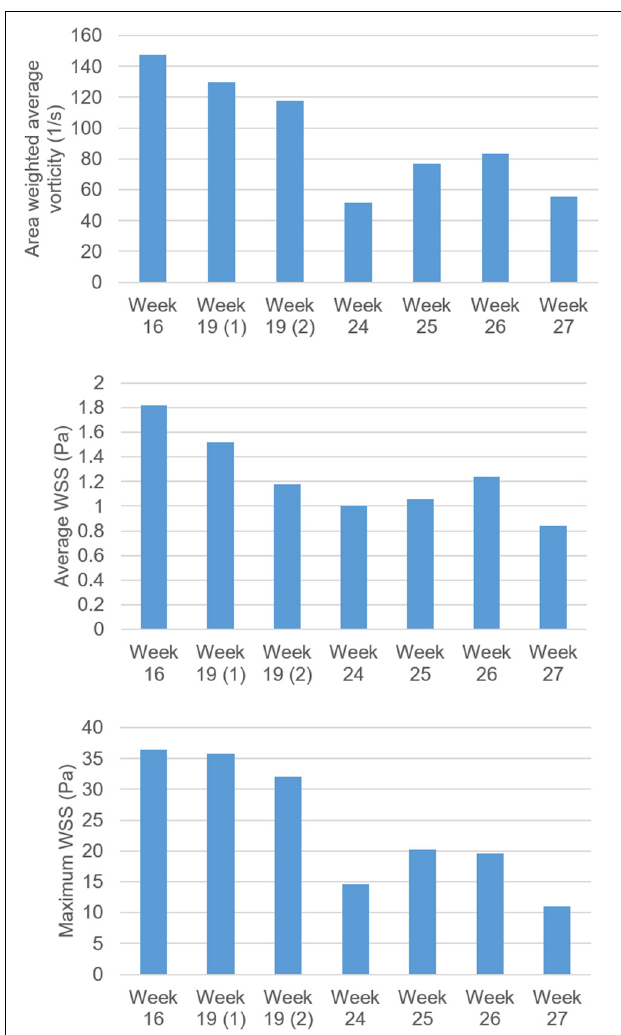
FIGURE 15 | Comparison of vorticity, average WSS and maximum WSS levels for fetal control hearts by weeks of gestation. The maximum WSS is observed on the mitral valve. There are two fetal heart analyses at week 19, which are shown as 19 (1) and 19 (2). For other gestational weeks, there is only one fetal heart analysis. The area weighted average vorticity and average WSS levels are determined by averaging the values in the flow domain during 0–0.25 s, corresponding to the first half of the cardiac